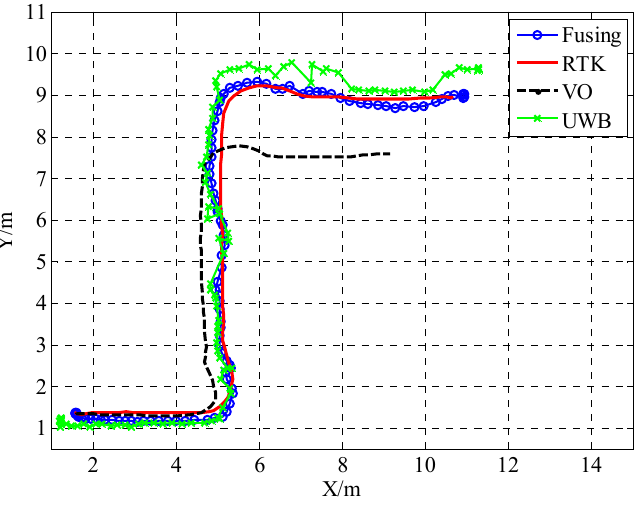
Figure 10. The comparison of trajectories in the X–Y plane.